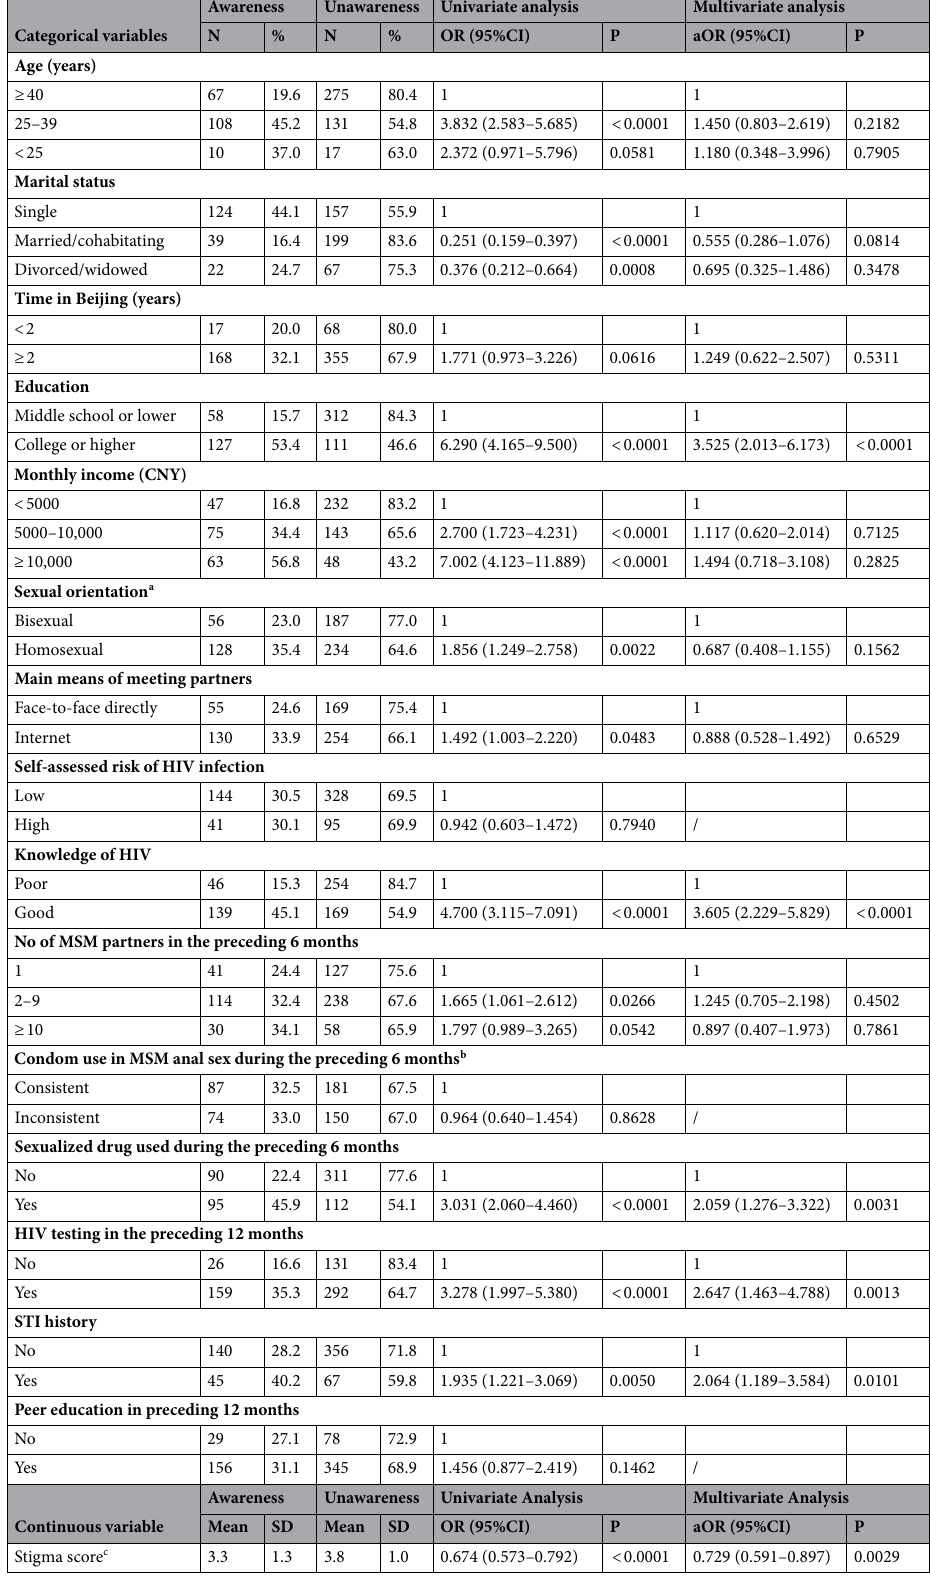
Table 3. Factors associated with the PrEP awareness among MSM recruited in 2021 in Beijing, China. a Sexual orientation removes heterosexuality and nonsexuality. b 492 MSM has MSM anal sex during the past six months. c measured on a 7-point scale from 0 to 6, 6 = extremely